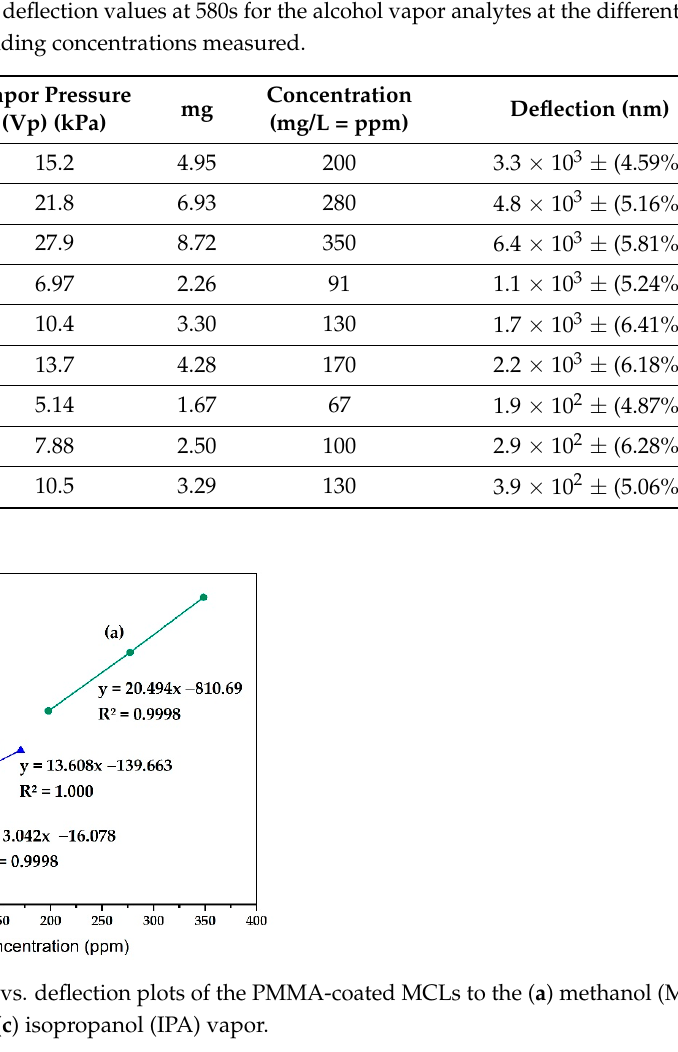
Figure 5. Sensitivity +/ − ~5% of the PMMA-coated MCLs to the three alcohol vapors tested.